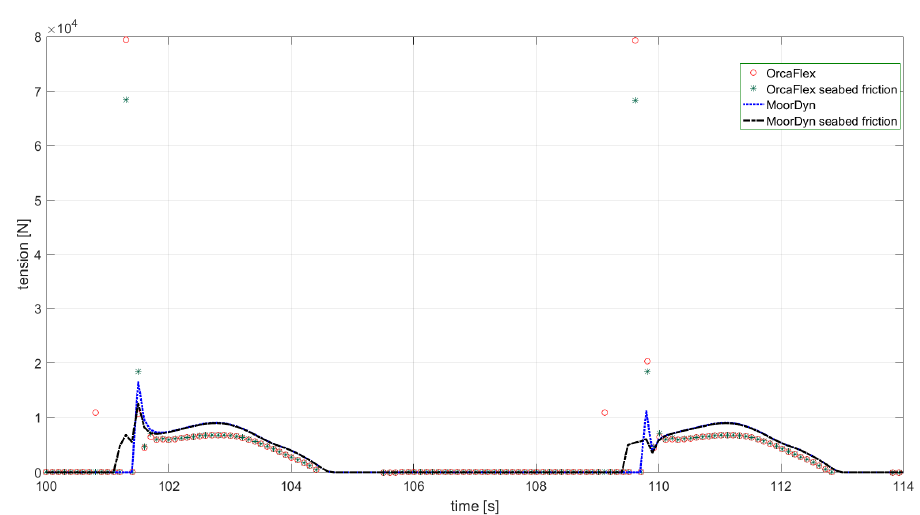
Figure 10. Simulation case 2: Anchor tension comparison at t = 100 s until t = 114 s.